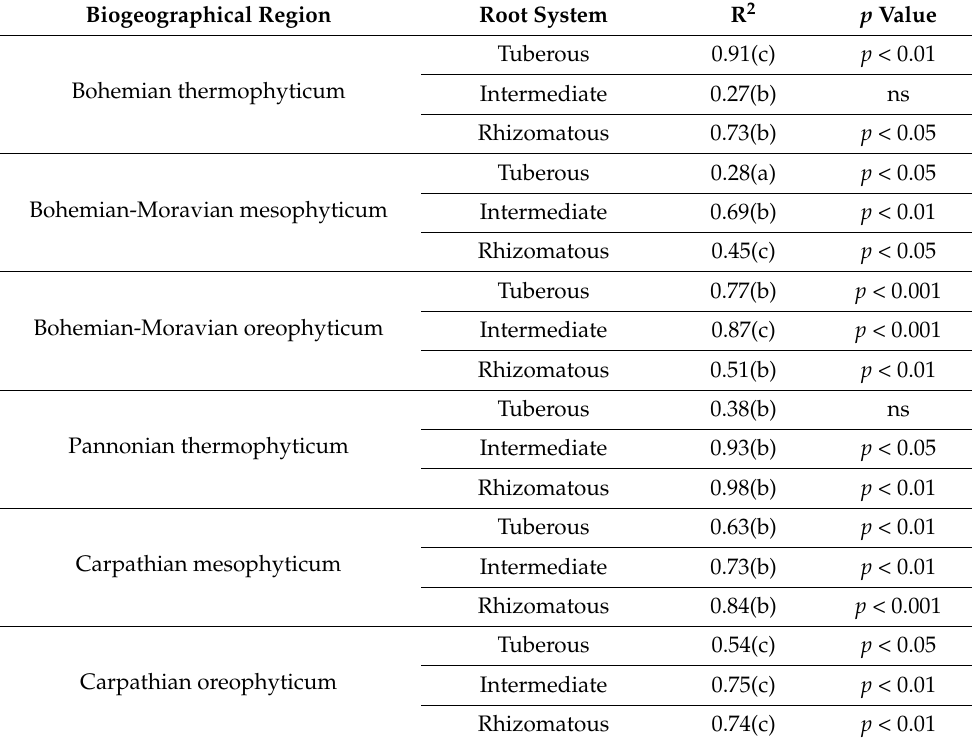
Table 3. Summary statistics of the polynomial regressions used for determining the relationship between mean Species Specialization Index ( SSI ) and